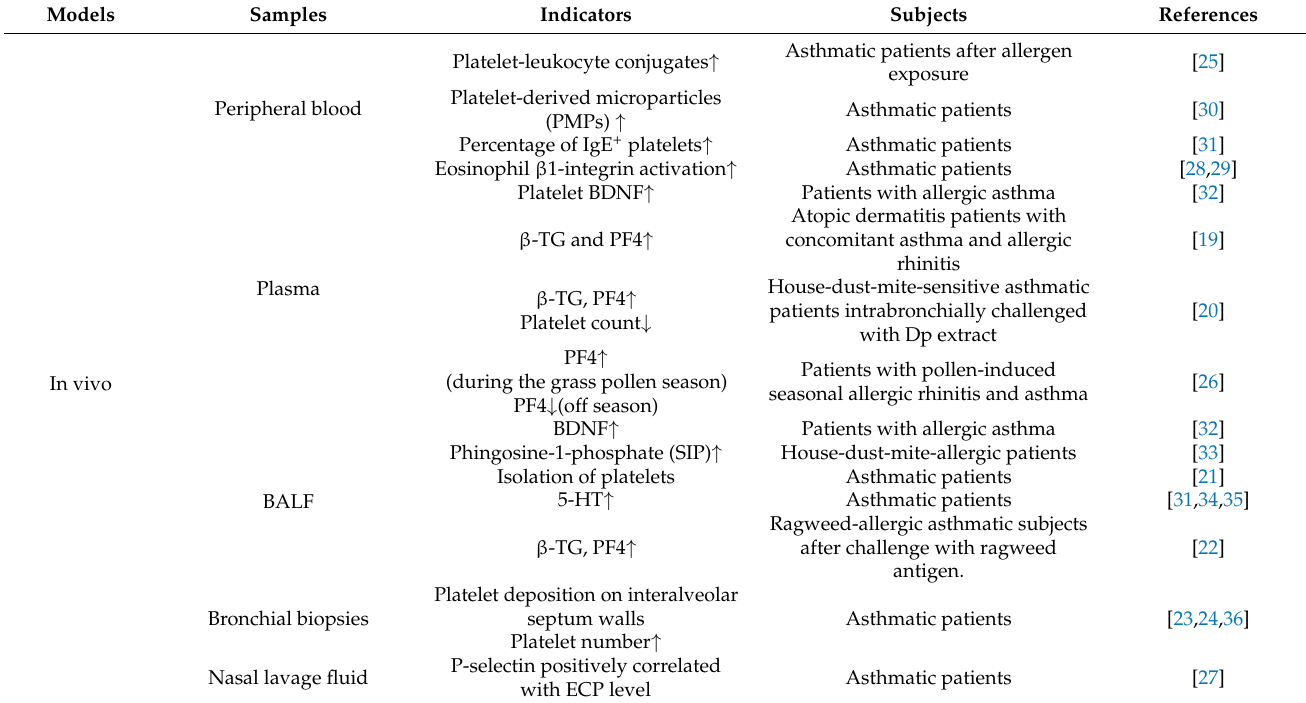
Table 1. Various platelet-derived factors in the pathogenesis of allergic asthma in humans.